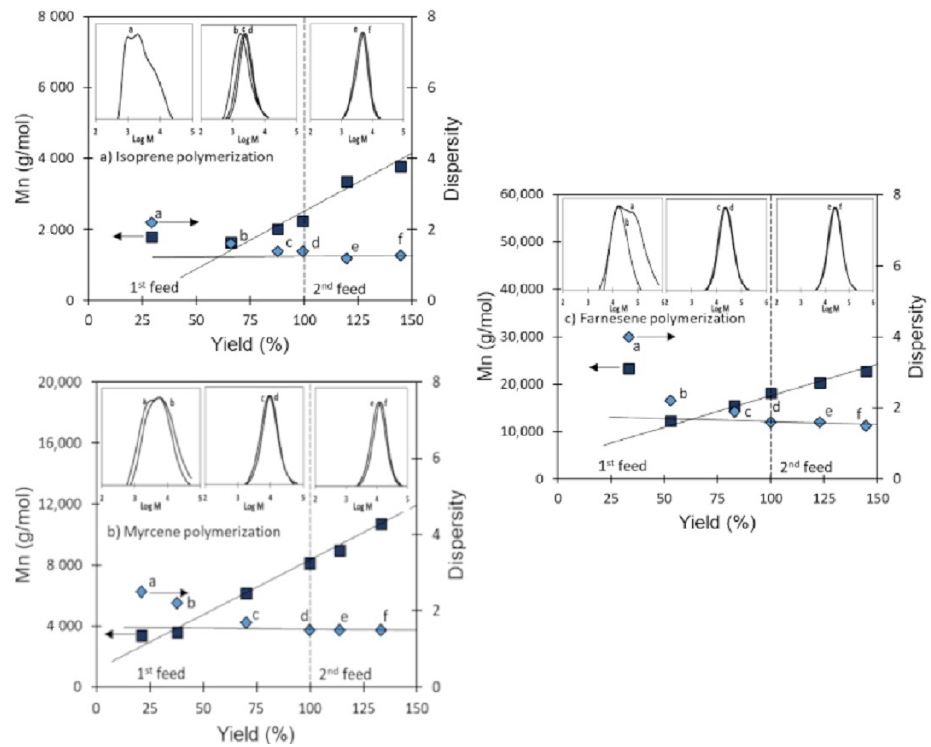
Figure 6. Dependence of M n and dispersity against yield in ( a ) Ip: entry Ip-11, ( b ) My: entry My-11, and ( c ) Fa: entry Fa-15, polymerizations initiated by NdV 3 /Al( i -Bu) 2 H/Me 2 SiCl 2 in cyclohexane at 70 ◦ C.